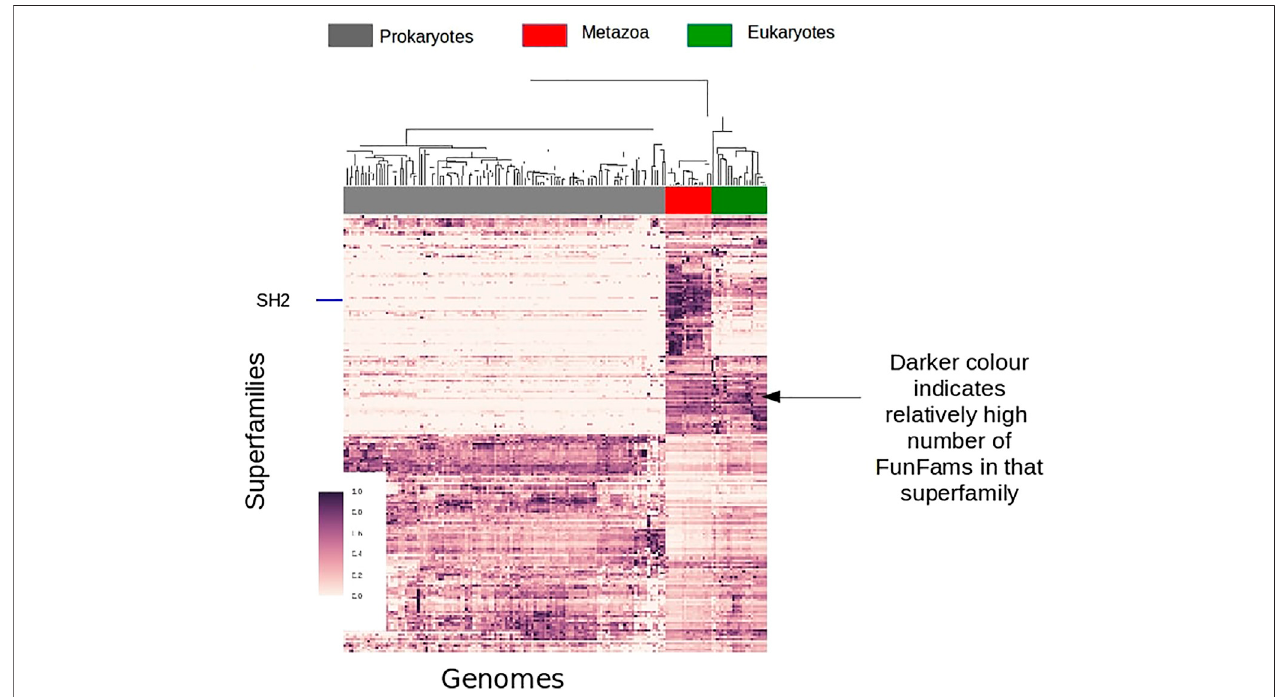
FIGURE 11 | Survey of FunFam expansions across the tree of life, darker colors show a higher number of FunFams in that superfamily.